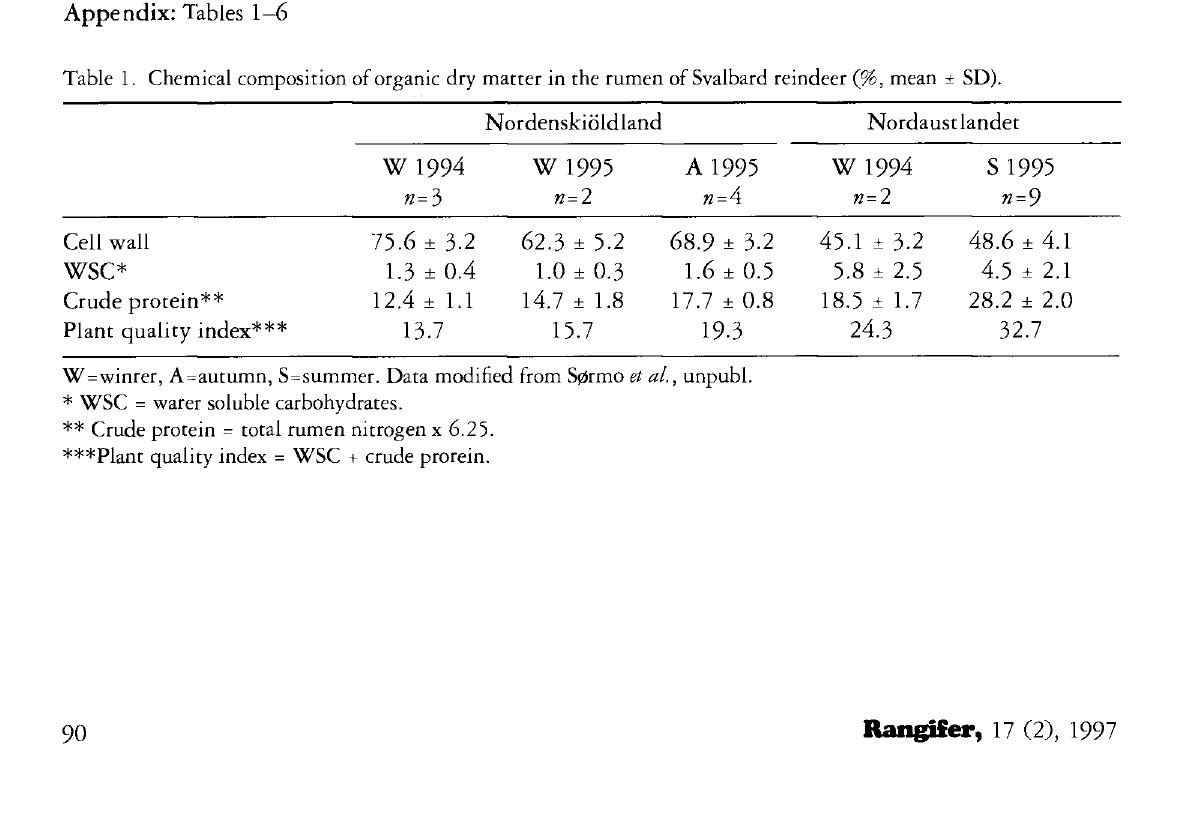
Table 1. Chemical composition of organic dry matter in the rumen of Svalbard reindeer (%, mean ±